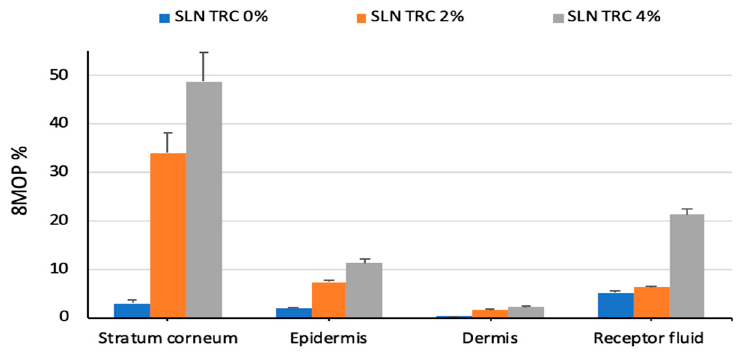
Figure 4. In vitro skin penetration and permeation studies: amount of 8-MOP accumulated in the skin layers (stratum corneum; epidermis; dermis) and receptor fluid after 8 h of non-occlusive application of the SLN. Each value is the mean ± standard deviation of six experimental